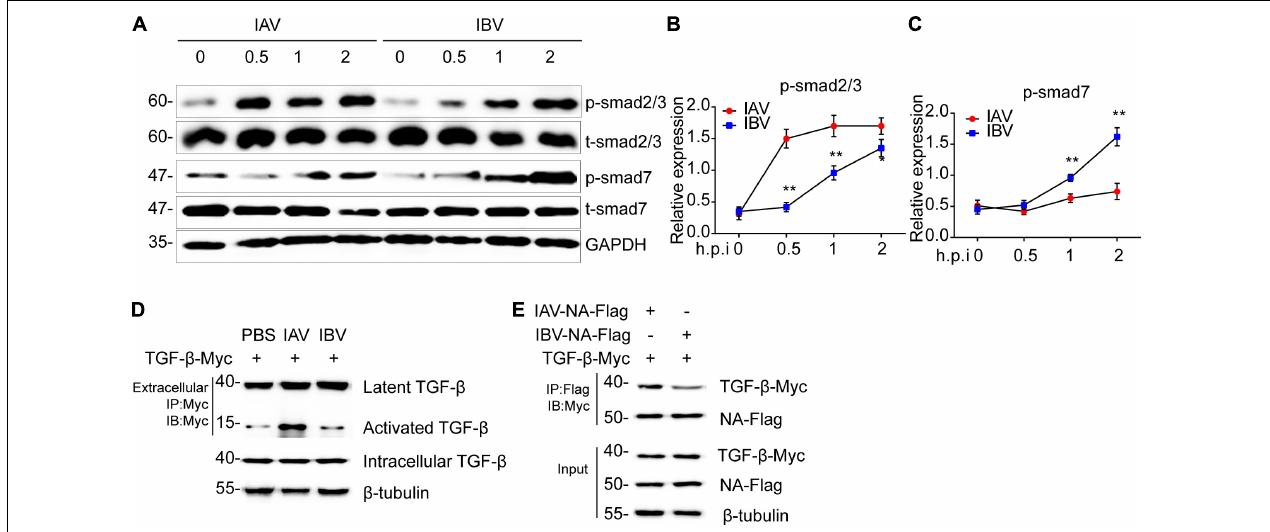
FIGURE 5 | Influenza A and B virus-activated TGF- β /smad2 signaling pathway is relevant to the binding ability of NA to latent TGF- β . (A) Immunoblot analysis of the phosphorylation of the indicated proteins in A549 infected with IAV (WSN) and IBV (Yamagata) (MOI = 0.005) for the indicated time-points. The relative expression of p-smad2/3 (B) and p-smad7 (C) in (A) . (D) Immunoblot analysis of the indicated proteins in immunoprecipitated samples from supernatant of A549 cells transfected with TGF- β -myc for 24 h and then stimulated by IAV and IBV (MOI = 0.005) for 2 h. (E) Immunoblot analysis of the indicated proteins in immunoprecipitated samples of A549 cells transfected with various combinations of plasmids for 24 h. Data are representative of three independent experiments. Data are presented as the mean ± SD for panels (B,C) . * p < 0.05 and ** p < 0.01 (unpaired, two-tailed Student’s t -test).